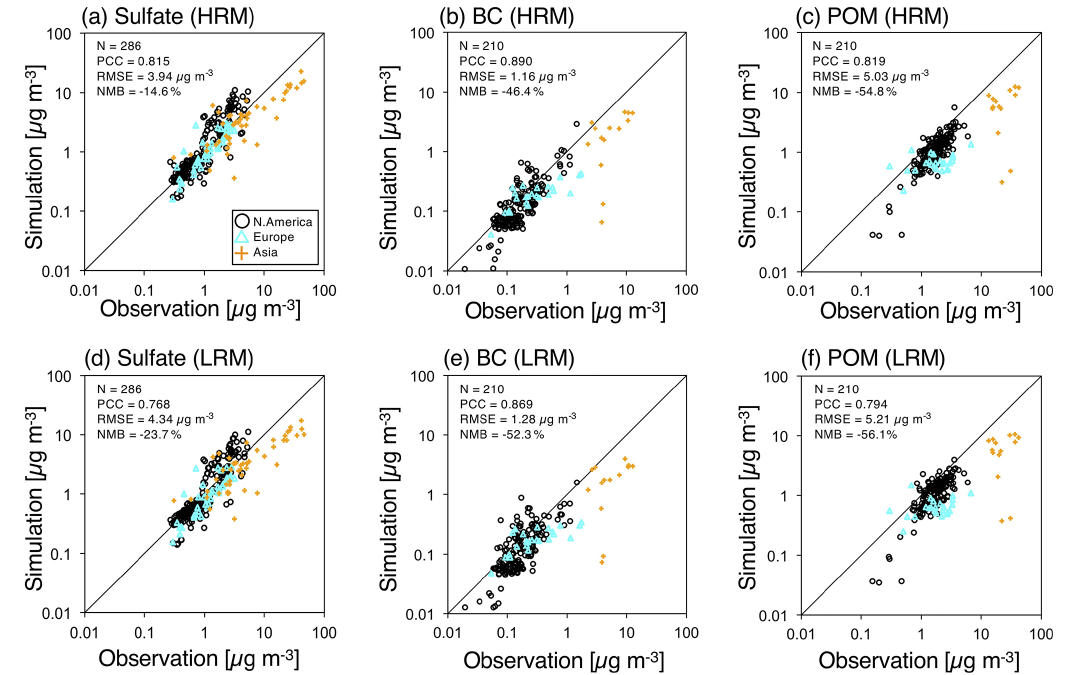
Figure 8. Scatterplots of the surface aerosol mass concentrations (sulfate, BC and POM) between satellite measurements (IMPROVE, EMEP, EANET and CAWNET) and the NICAM (HRM and LRM) simulations for the annual averages. All units are in µgm − 3 . The different colors and marks reflect the sites in the different regions explained in panel (a) . The numbers located in the upper-left corner in each panel represent the statistical metrics: N , PCC, RMSE and NMB. The statistical metrics are also shown in Table S6. The sites employed for the comparison are shown in Fig.